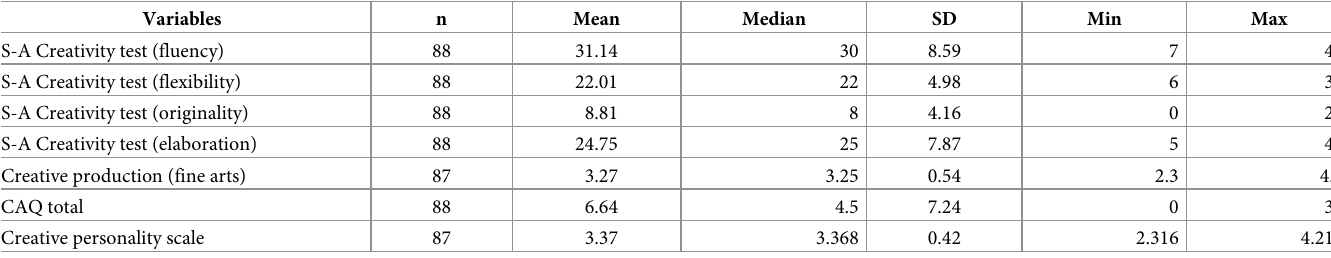
Table 1. Descriptive statistics of the creativity